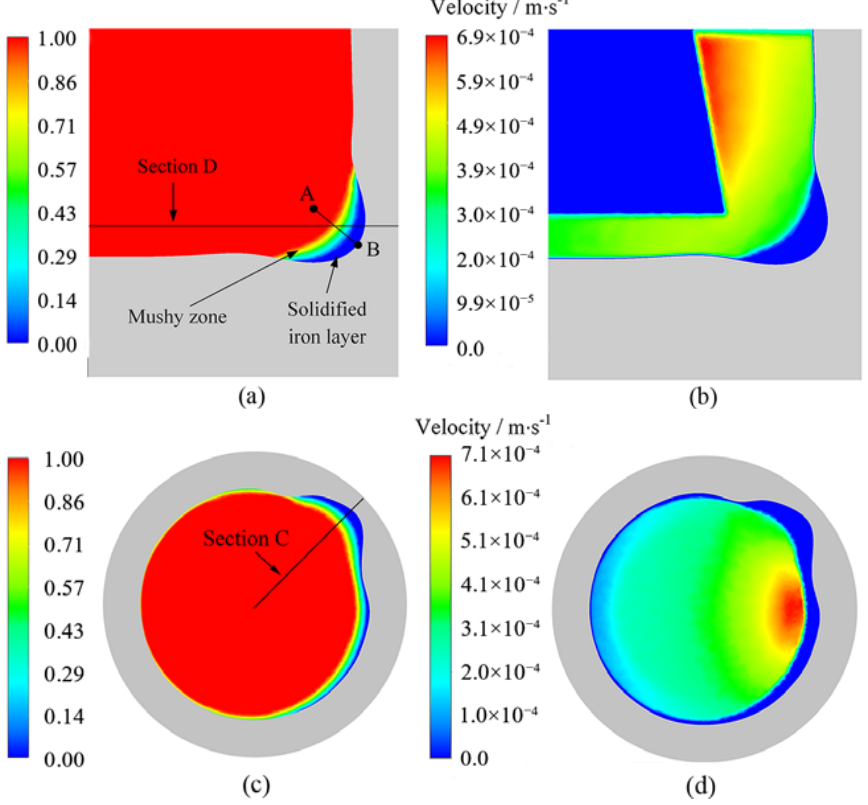
Figure 7. Calculation results of normal production. ( a ) volume fraction of hot iron at section C. ( b ) hot iron flow rate at section C. ( c ) volume fraction of hot iron at section D. ( d ) hot iron flow rate at section D.